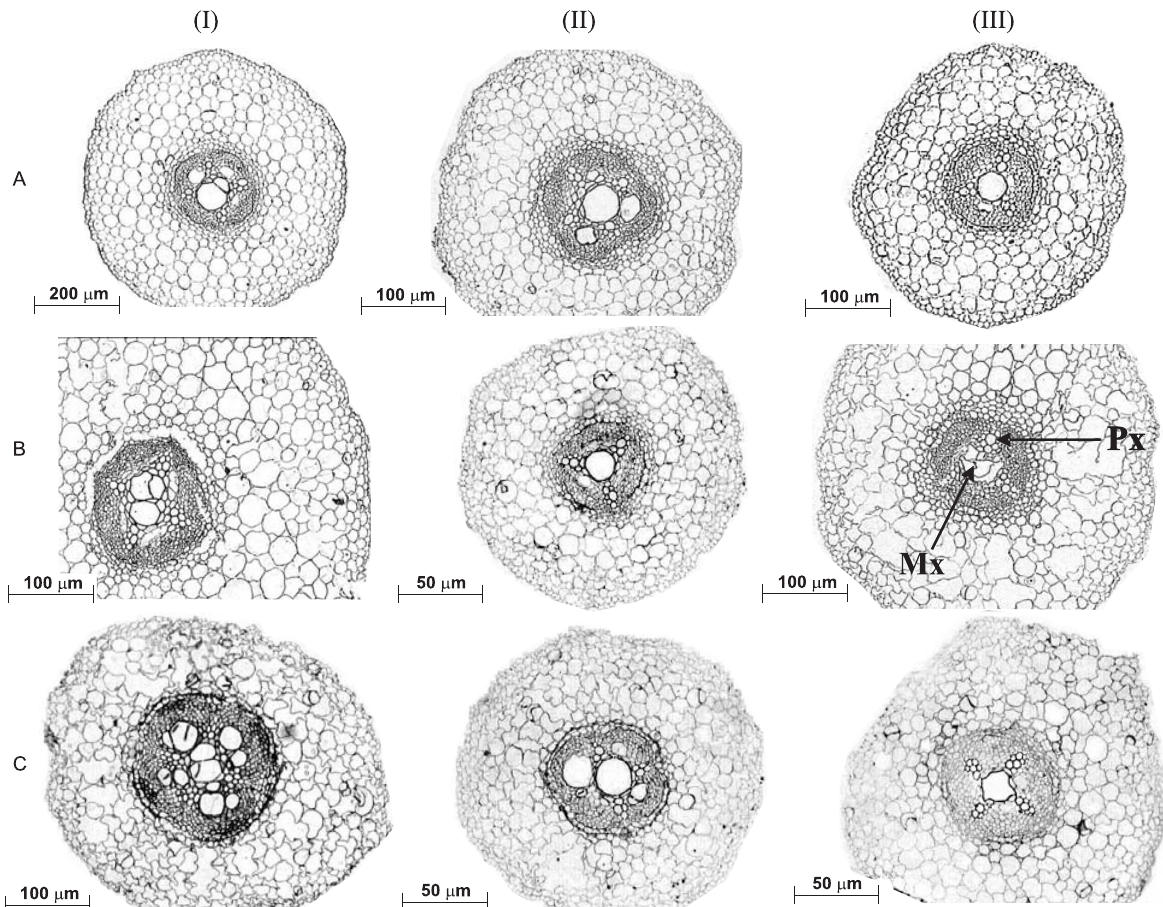
Figure 1. Root cross-sections 10 mm from the root tip of the three soybean cultivars Santa Rosa (I); IAC-15 (II) and IAC-Foscarin 31 (III), as related to Mn rates of 0.5 μμμμμ mol L -1 (A), 2.0 μμμμμ mol L -1 (B) and 200.0 μμμμμ mol L -1 (C), in nutrient solution. Anatomical features of the primary tissues: root cortex and bundle sheaths (xylem vessels). Xylem vessels detail (arrow) – protoxylem (Px) and metaxylem